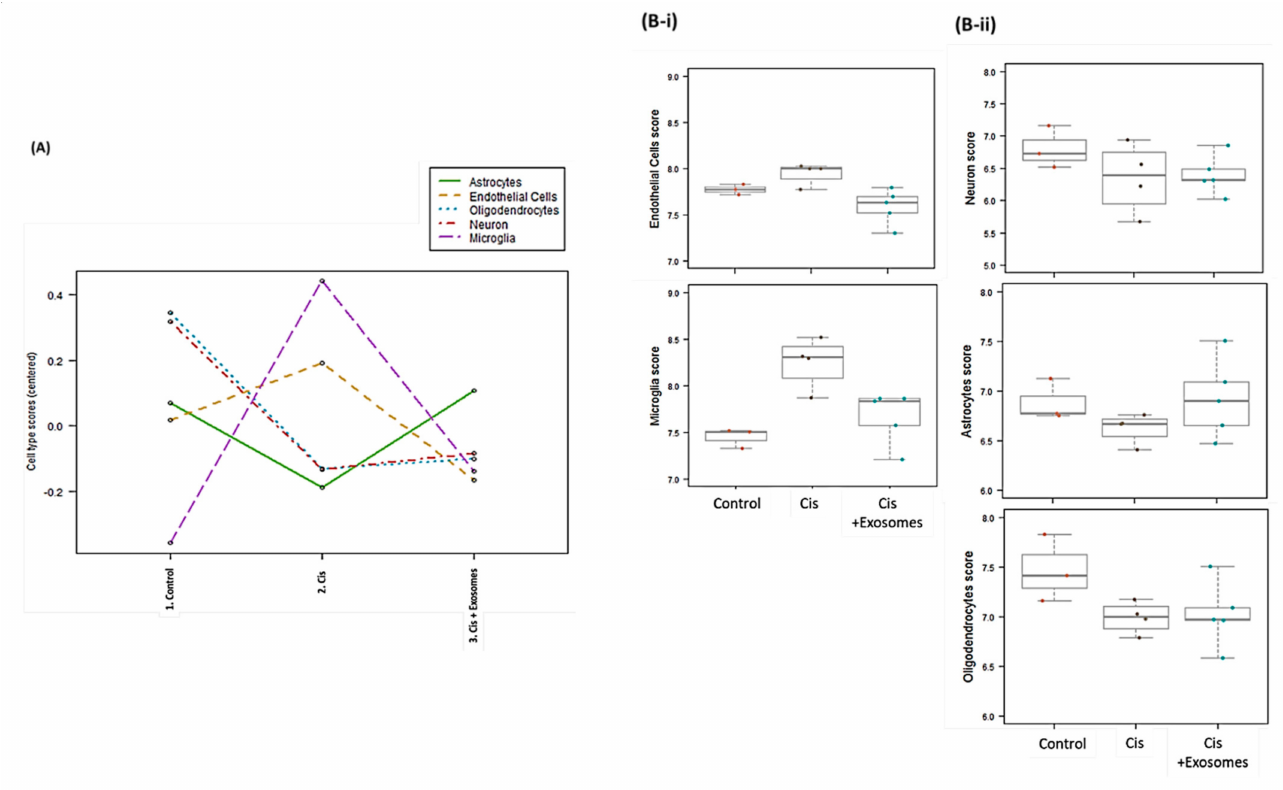
Figure 7. Neuropathological gene panel analyses of the involved cell types in the cochlear tissues from mice receiving chronic cisplatin injection. ( A ) Summary of the scores of cell types in the mRNA expression profiles of the cochlear tissues in three representative mice per group. ( B ) Increases and decreases in those